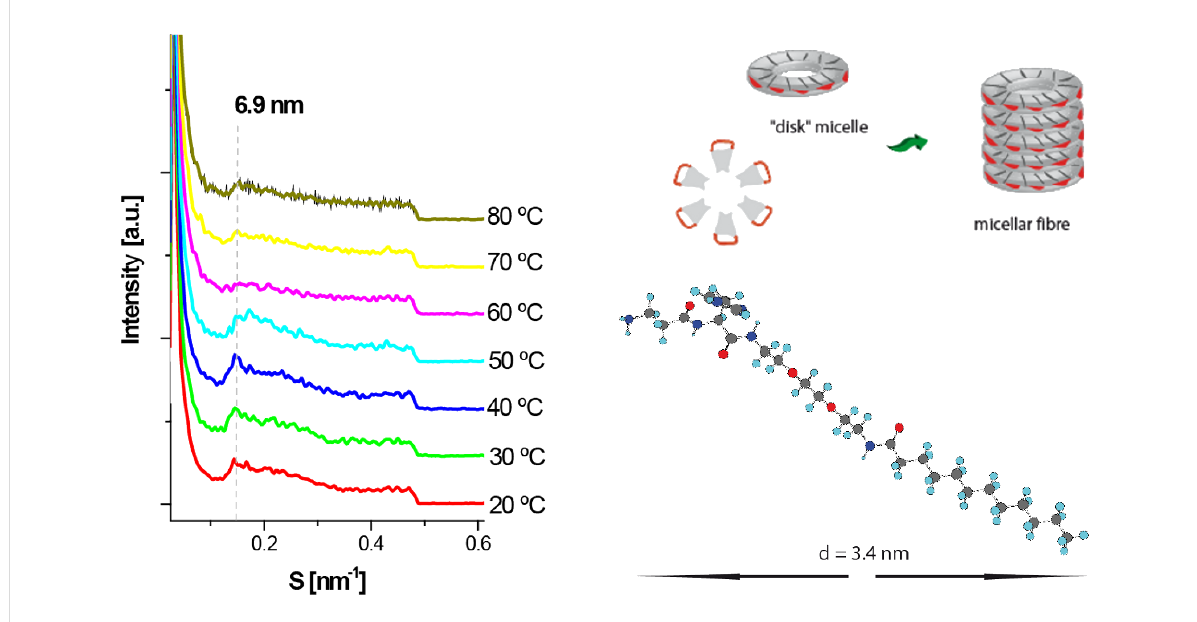
Figure 3: SAXS profile of concentrated gel of β -Ala-His-EO 2 -C 14 at different temperatures (where S = 2 π /q and q is the scattering vector).